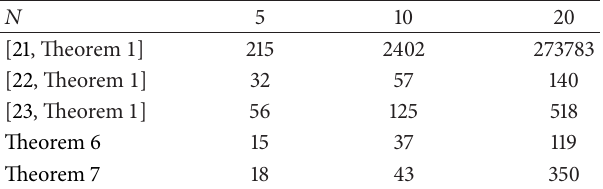
Table 1: The smallest eligible value of the parameter 𝛽 , 𝛽 𝑚